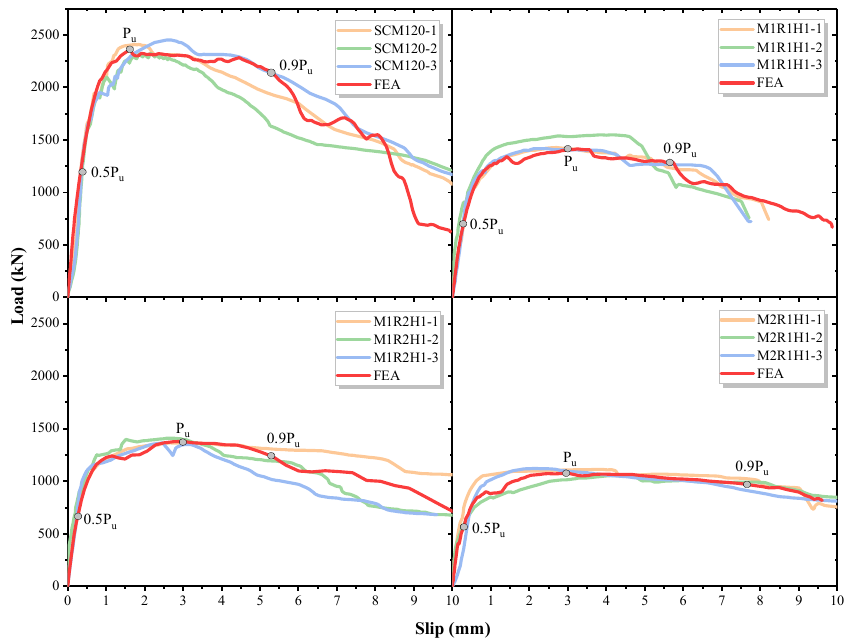
Figure 11. Comparison of load-slip curves from tests and FE model. Table 3. Comparison of FEA results with push-out